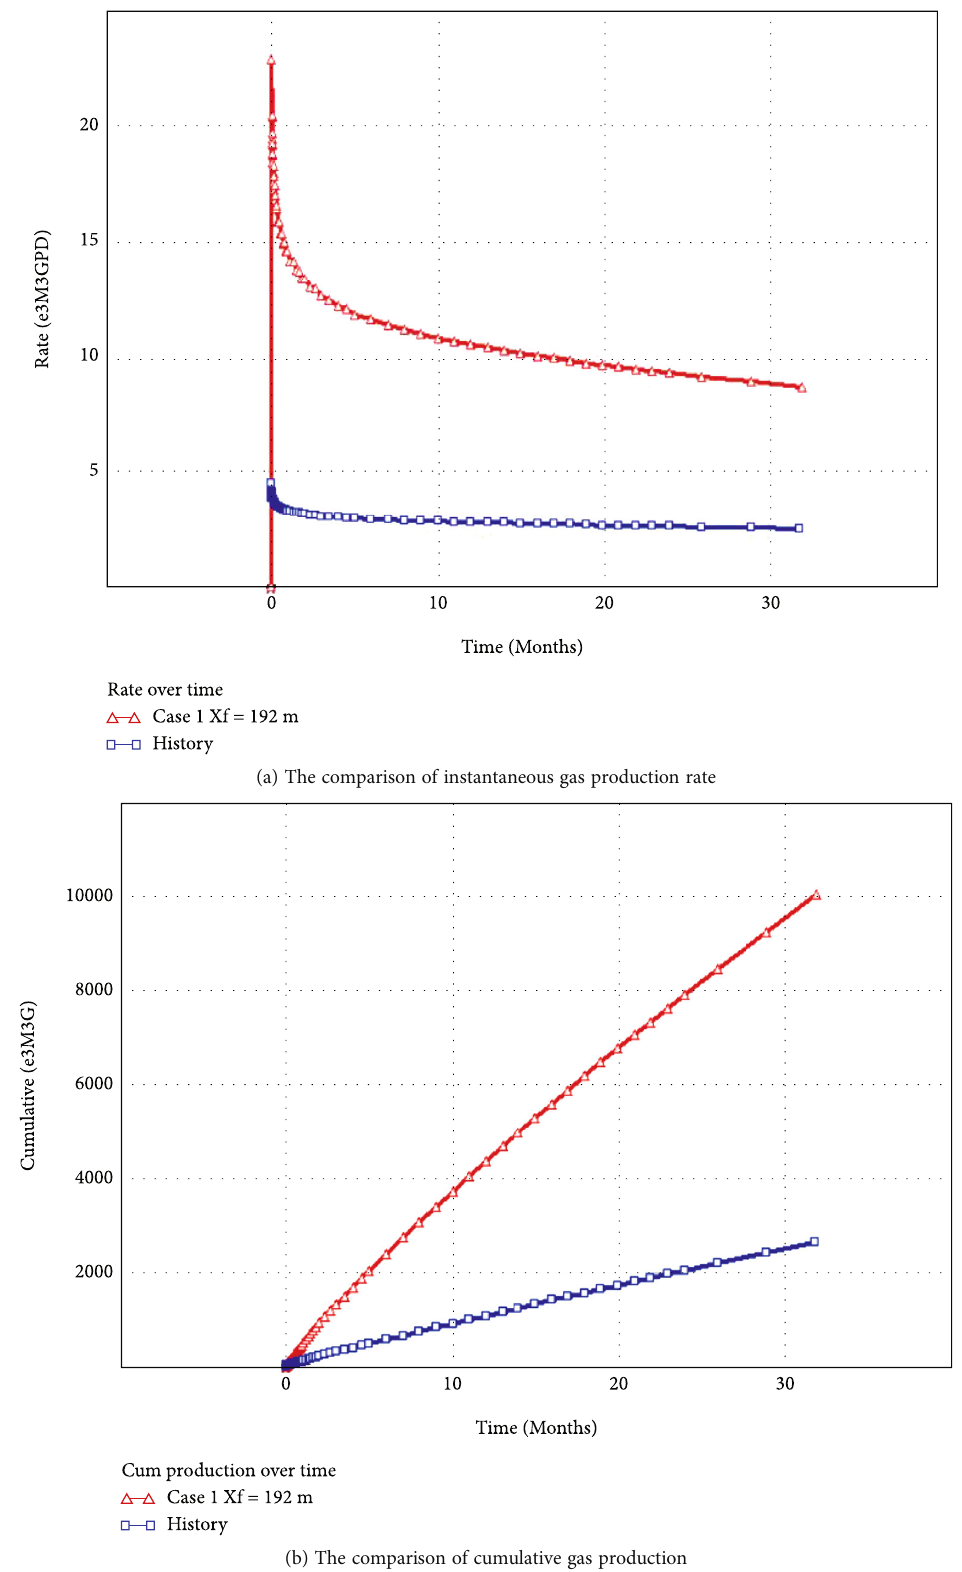
Figure 21: The comparison of gas production for the original and optimized hydraulic